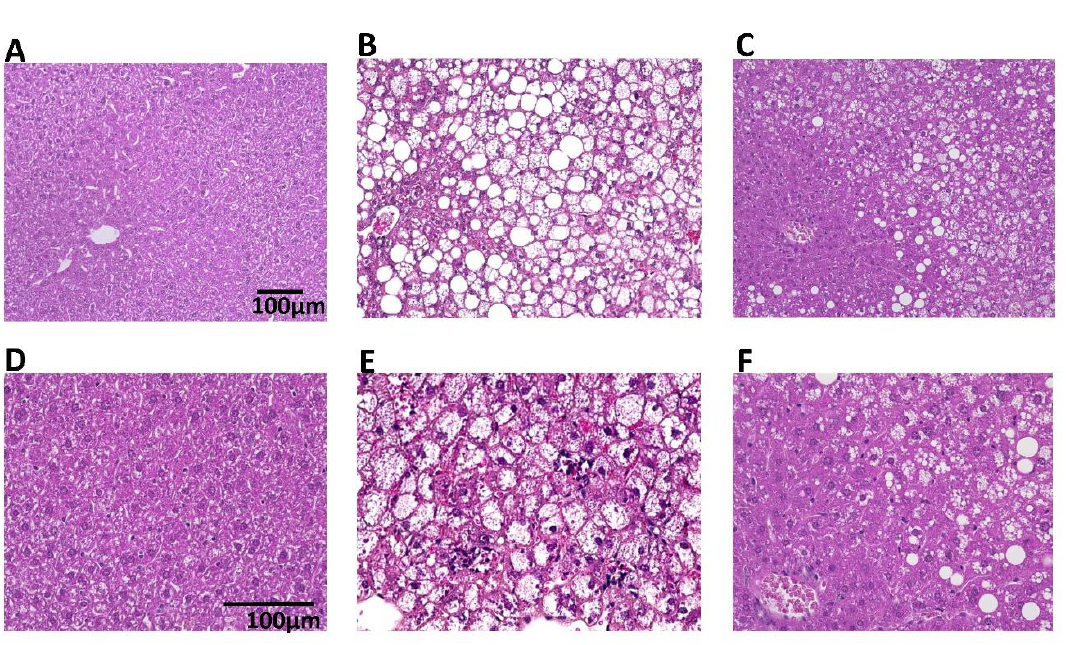
Figure 3. Representative microscopic images of the liver of mice treated with or without BTS. The liver was taken from mice fed with or without 5% (w / w) BTS for 4 weeks. The specimens were stained with hematoxylin and eosin and examined by light microscopy. ( A , D ) WILD group, ( B , E ) CONT group, ( C , F ) BTS group, ( A – C ) × 20 magnitude, ( D – F ) × 40 magnitude.